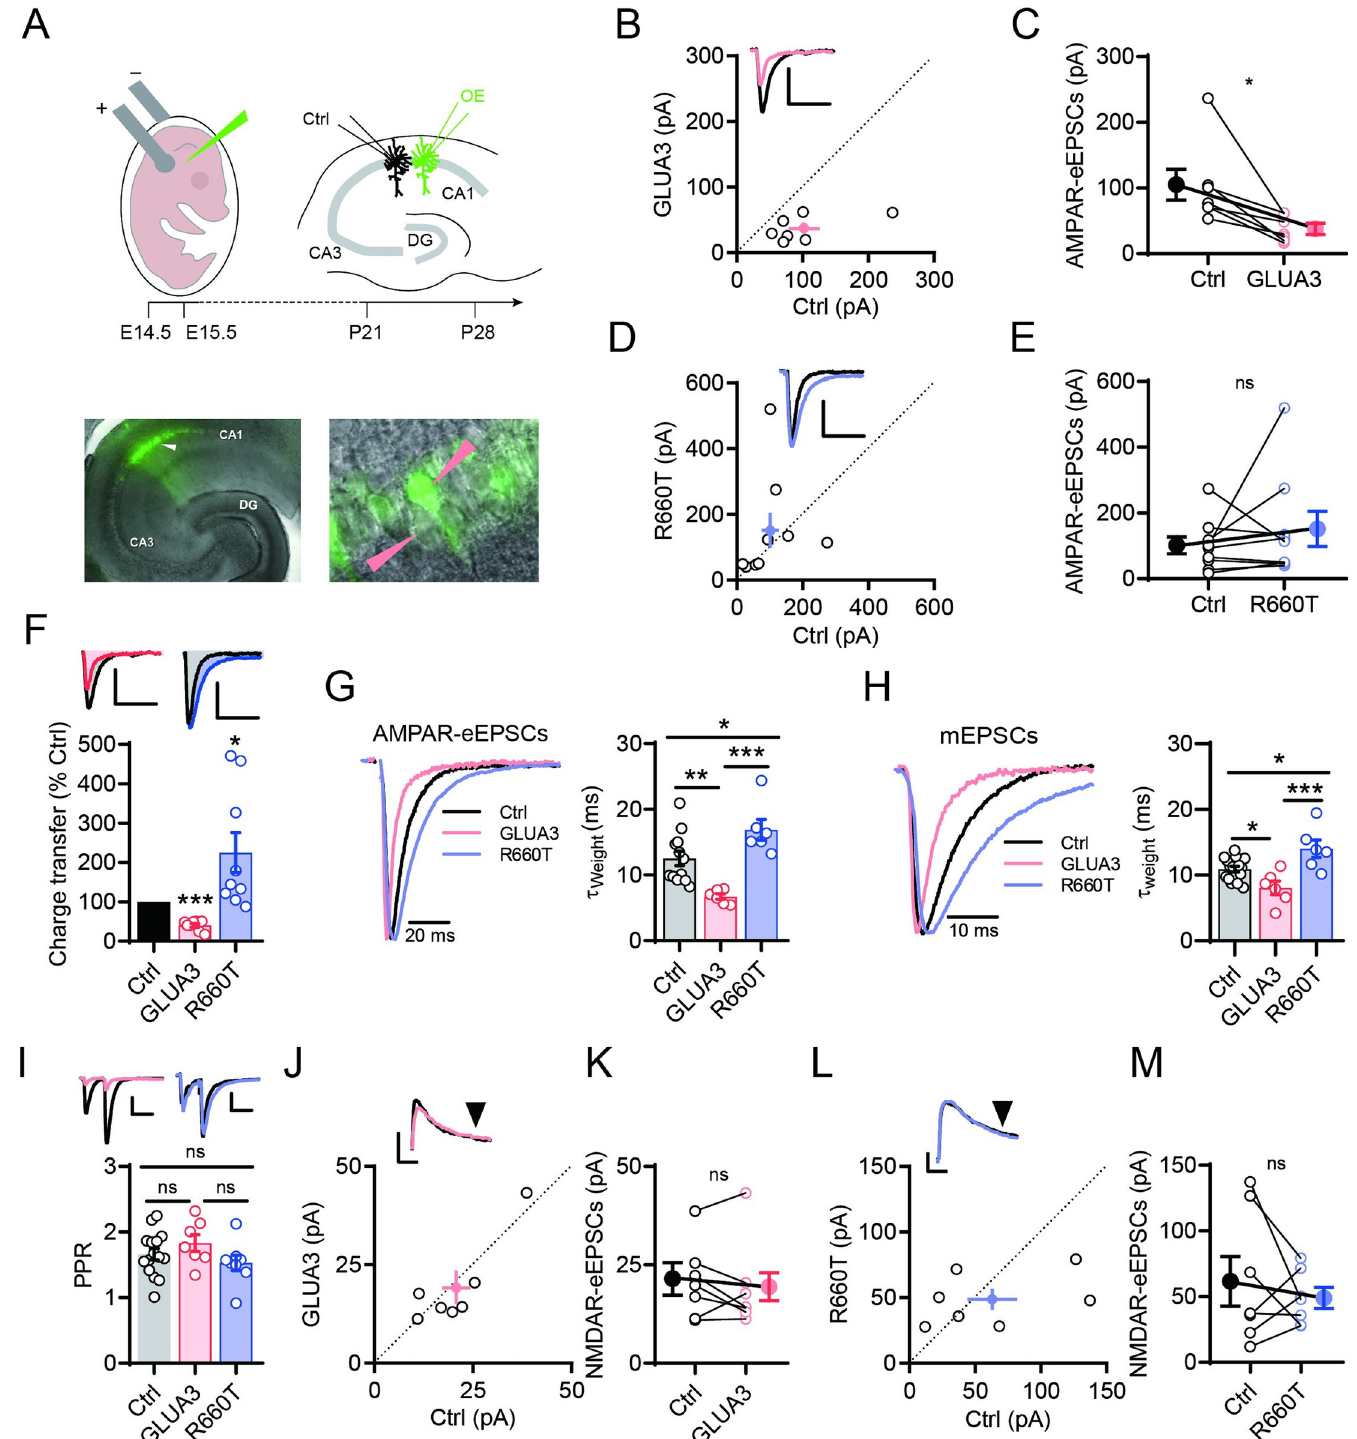
Fig 6. Overexpression of GLUA3 and R660T regulate AMPAR-EPSC decay in hippocampal CA1 pyramidal neurons. (A) Up panel, schematic of IUE and dual whole-cell recordings in hippocampal CA1 neurons. Lower left panel, photographs of GLUA3-IRES-GFP transfected CA1 pyramidal neurons on hippocampal acute slice. Lower right panel shows the magnified image around the white arrowhead at the left panel. Pink arrowheads point to a transfected neuron (Green) and a control neuron (no color) that were selected for dual recording. (B) Circles present dual recordings of evoked AMPAR-eEPSCs of GLUA3-transfected (GLUA3) and control (Ctrl) neurons. Filled doc with bars is mean ± SEM of the recordings. Inserted sample traces are from Ctrl (black) recording paired with GLUA3 (pink). Scale bars,